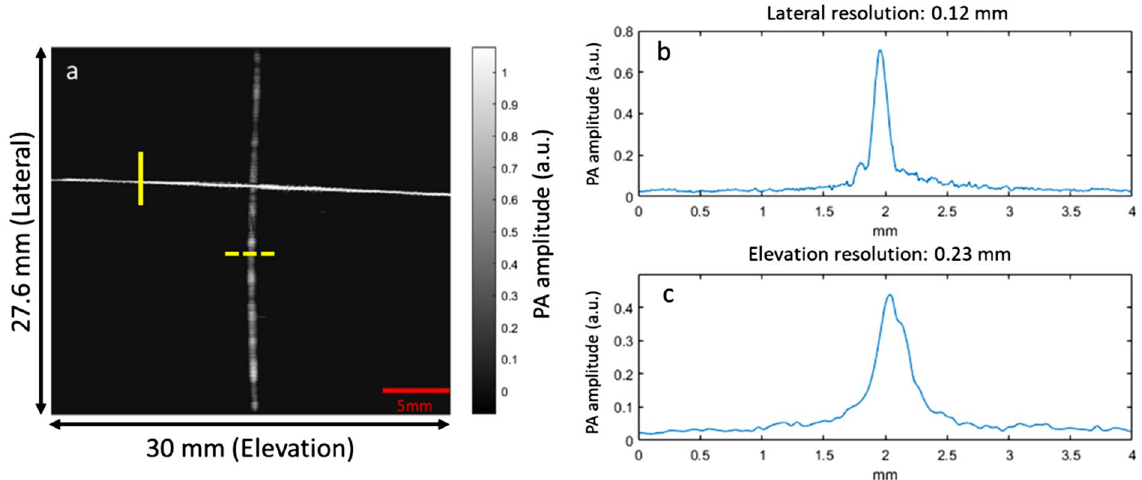
Figure 2. Quantification of lateral and elevation resolutions of the fingerprint imaging system, using human hair. ( a ) PAT image of two hairs perpendicular to each other. ( b ) Lateral resolution as quantified by PA signal intensity along the solid yellow line in ( a ). ( c ) Elevation resolution as quantified by PA signal intensity along the dashed yellow line in ( a